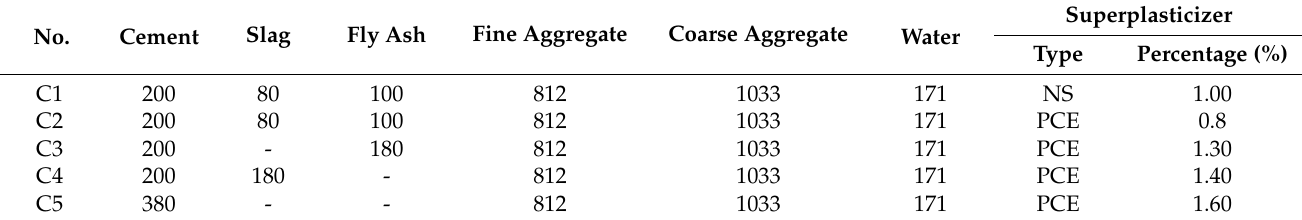
Table 2. Concrete mix proportions (kg/m 3 ).